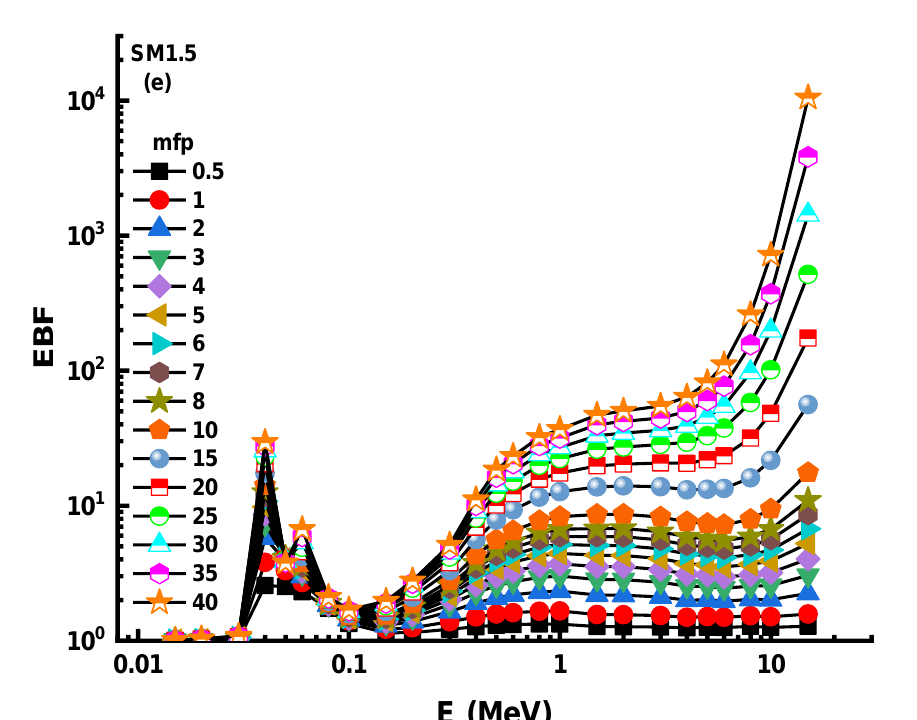
Figure 9. ( a – e ) . Variation of exposure buildup factor (EBF) against Photon energy for all glasses.